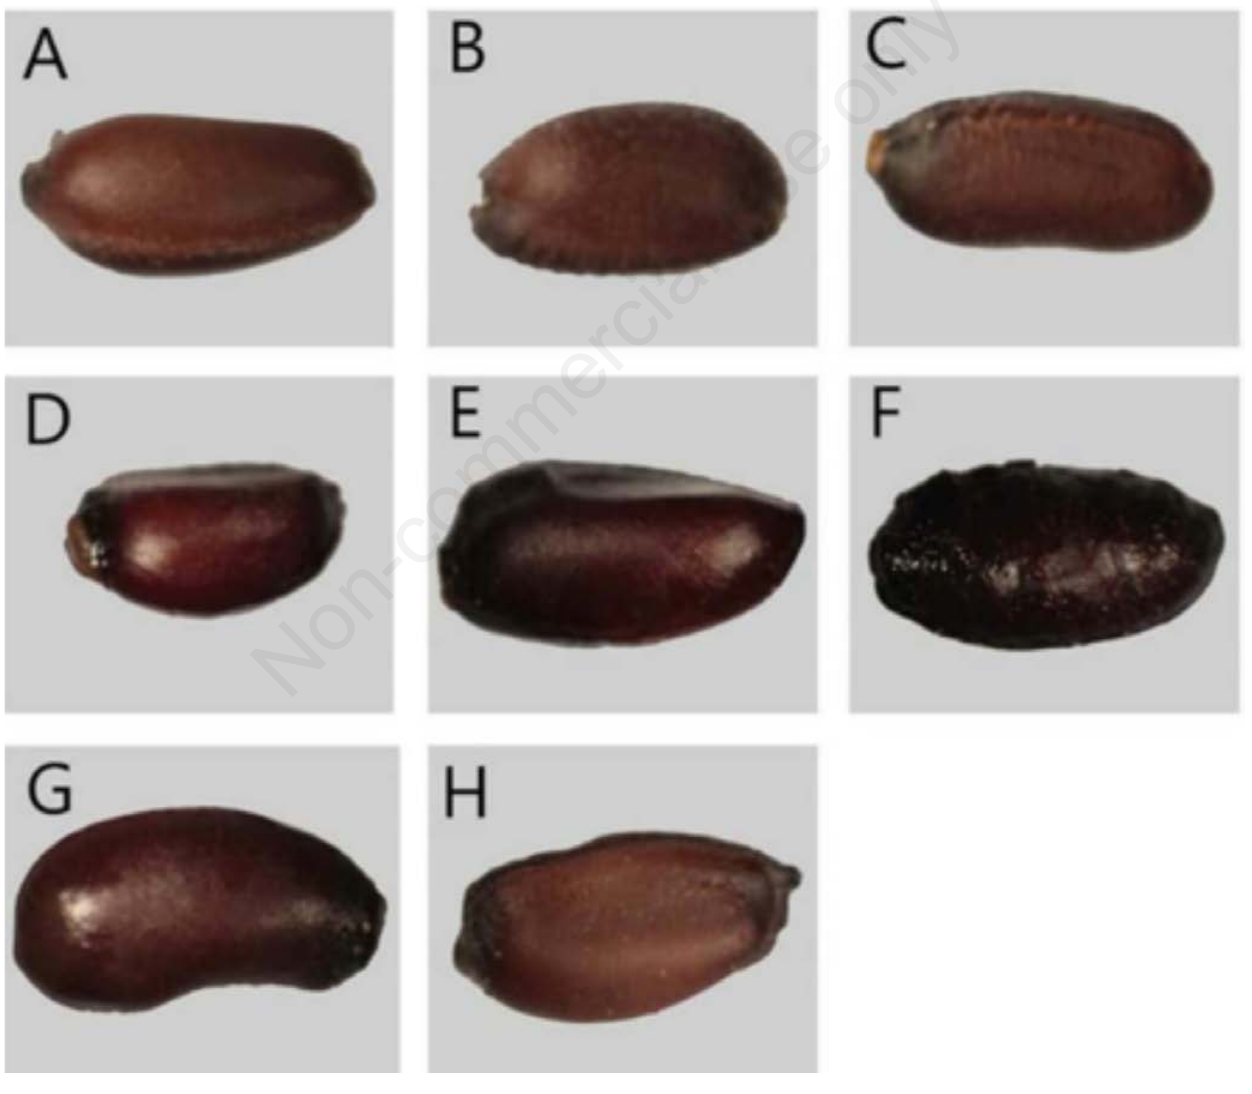
Figure 1. Seed morphology OF Calycanthaceae from stereo microscope. A, Sinocalycanthus chinensis ; B, Calycanthus occidentalis ; C, Chimonanthus praecox ; D, Chimonanthus nitens ; E, Chimonanthus fragrans ; F, Chimonanthus salicifolius ; G, Chimonanthus yunna- nensis; H, Chimonanthus luteus (Without scale; A-H).